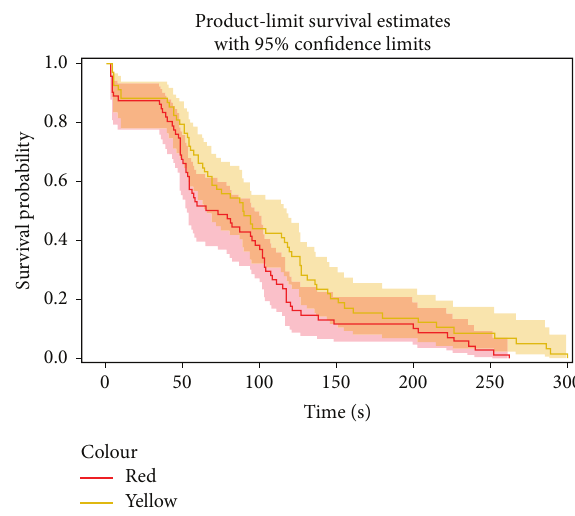
Figure 5: The Kaplan-Meier estimate of the survival function (probability of cyclic resistance) of rotary instruments categorized by the size coding by ISO standards (yellow for size 20, red for size